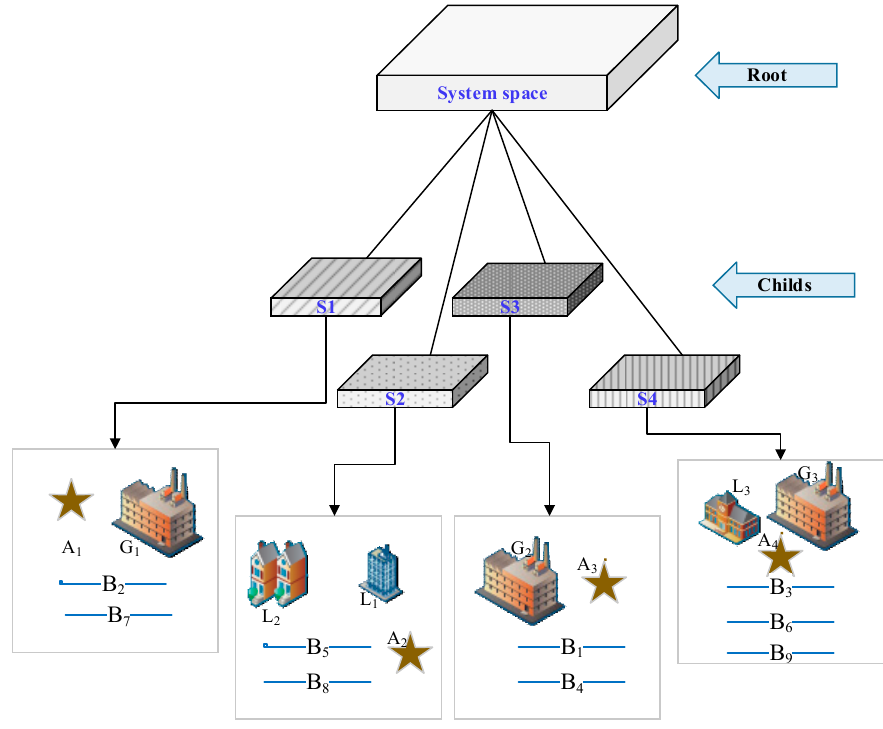
Figure 3. Weighted quad tree (WQT) based system partitioning.